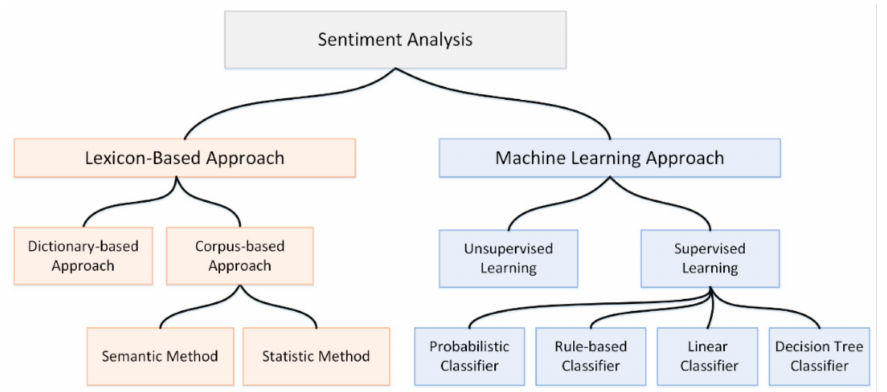
Figure 2. Diagram of sentiment analysis